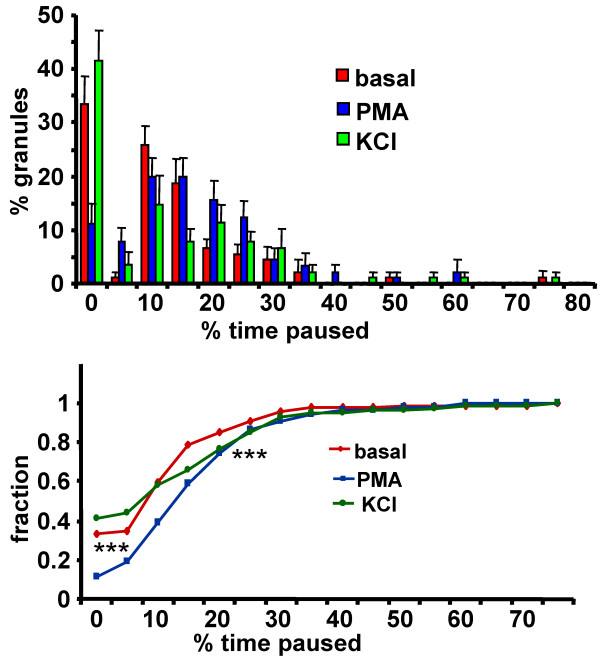
PMA increases LDCV pausing time in axons. The effect of secretagogue on the percentage of time that LDCVs in axons spent paused was calculated; to be categorized as 0% paused, a LDCV had to be in continuous motion. The distribution of binned data is shown.